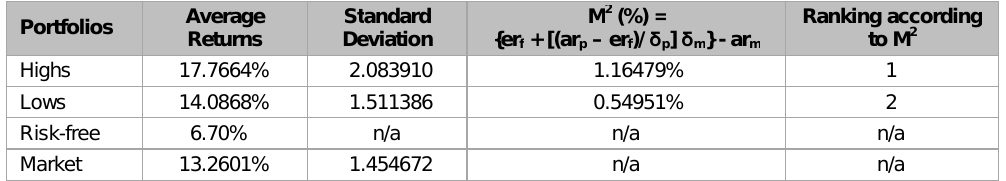
Average Returns, Standard Deviations and M 2 of